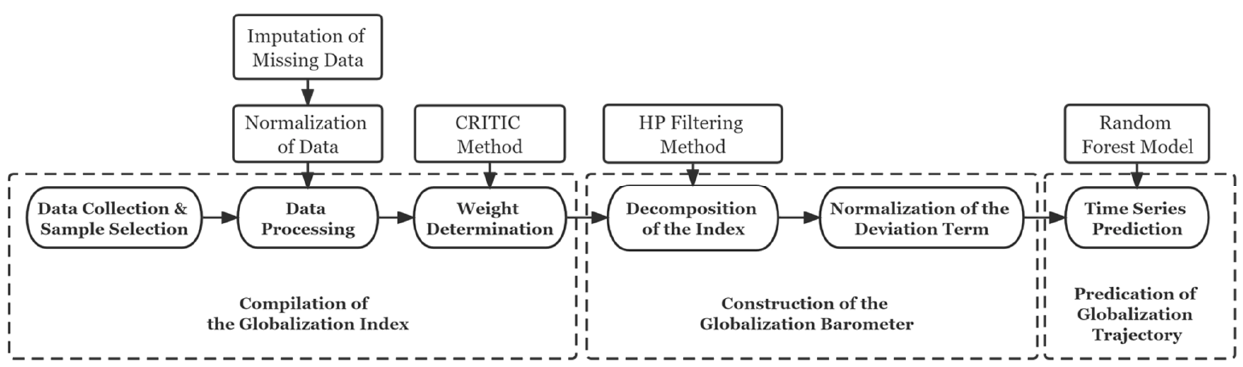
Figure 1. Methodology procedures.